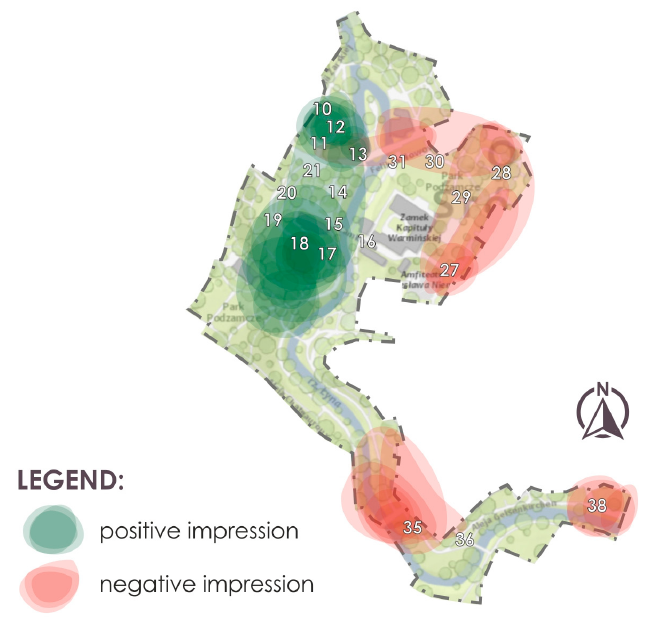
Figure 15. Mental map of the Podzamcze Park. Respondents identified noisy spaces (red) and noise-free and positive-sounding spaces (green).